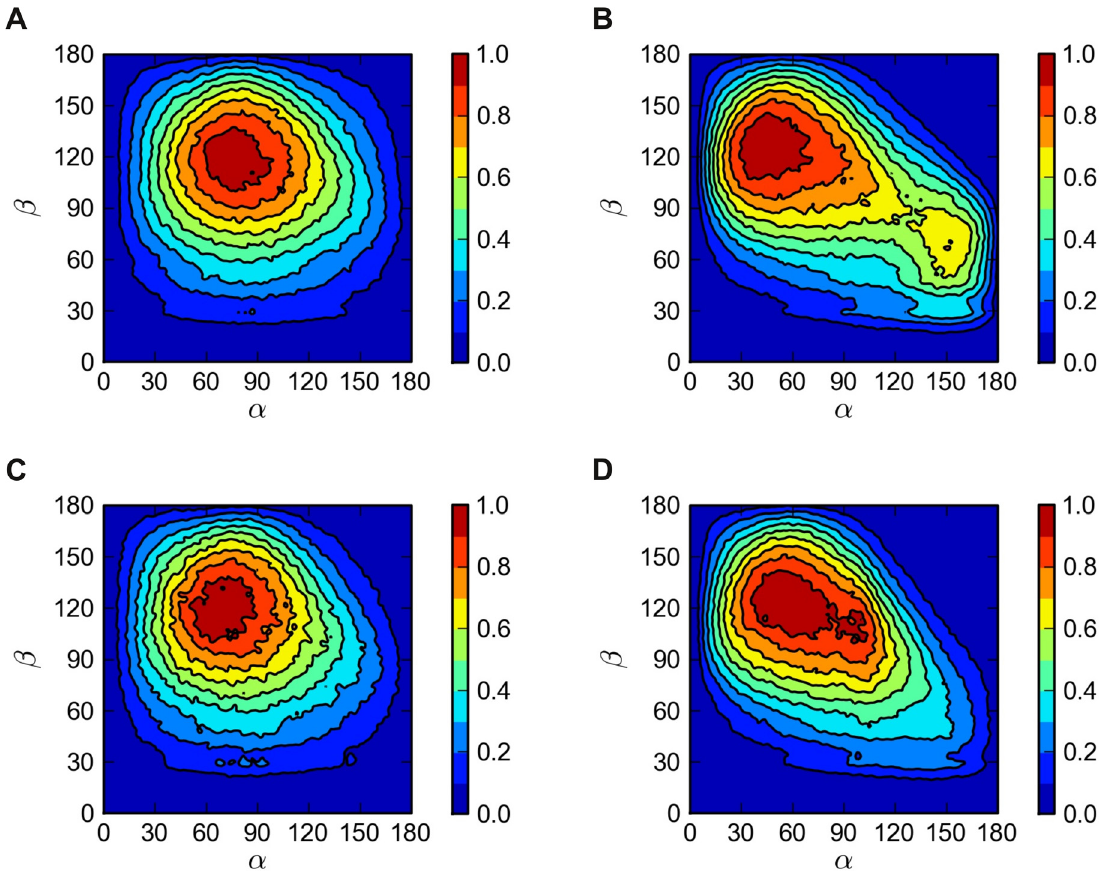
Figure 5. Distributions of CE conformations. The horizontal axis is the angle a between the CE ring and the effective normal of the lipid droplet. The vertical axis is the angle b between the ring structure and the oleate chain. The left panels (A, C) describe the core of the droplet ( r v 2 nm) and the right panels (B, D) the surface ( r w 3 nm). The pictures at the top (A, B) show the lipid droplet without apoA-I and those at the bottom (C, D) the full HDL.